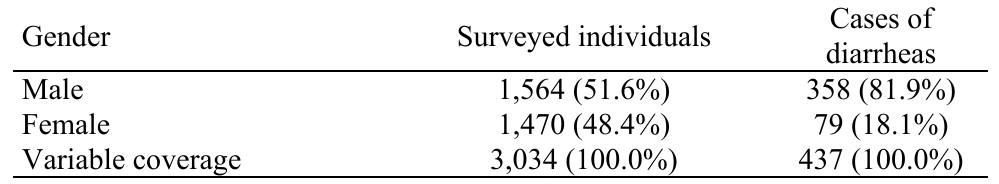
Table 1. Distribution of diarrheal diseases, according to gender in